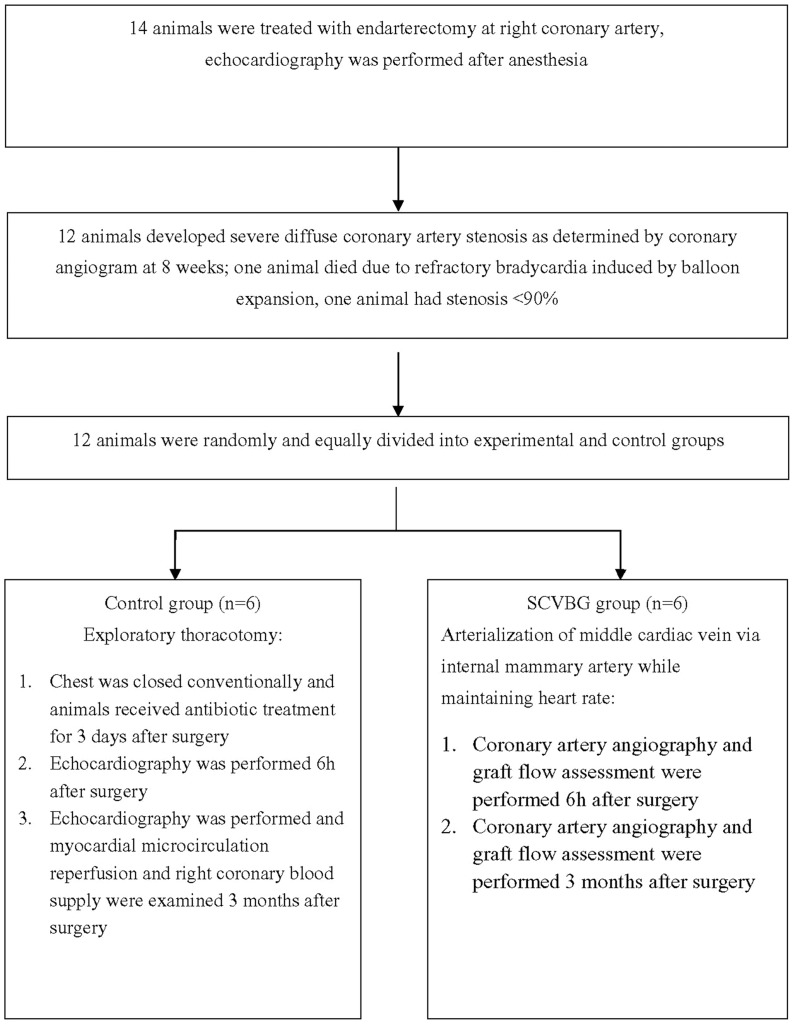
Animal model construction.